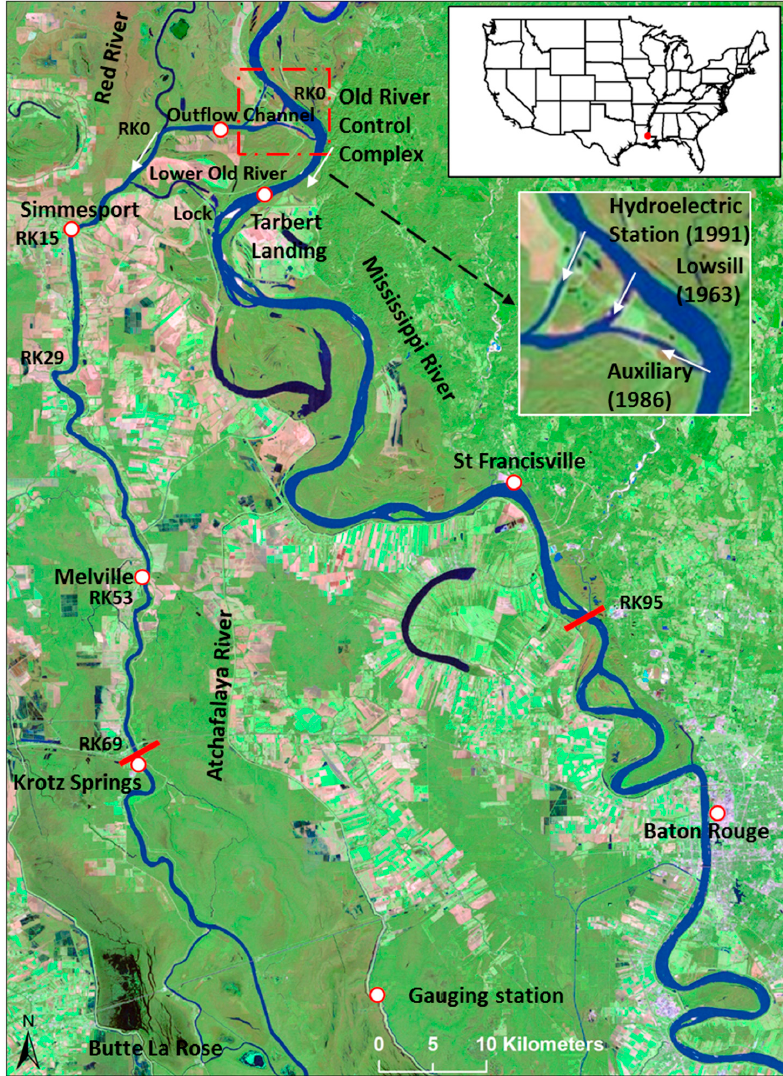
Figure 1. The uppermost Atchafalaya River (left) and the Lowermost Mississippi River (right). The Mississippi-Atchafalaya River diversion (also known as the Old River Control Complex) has three diversion channels, controlling the amount of flow into the Atchafalaya River at an approximately 25–75% ratio. The Outflow Channel/Red River confluence mainly controls sediment and water discharge, while the Lower Old River is locked and used for navigation. The background image is a Landsat imagery (Band742).